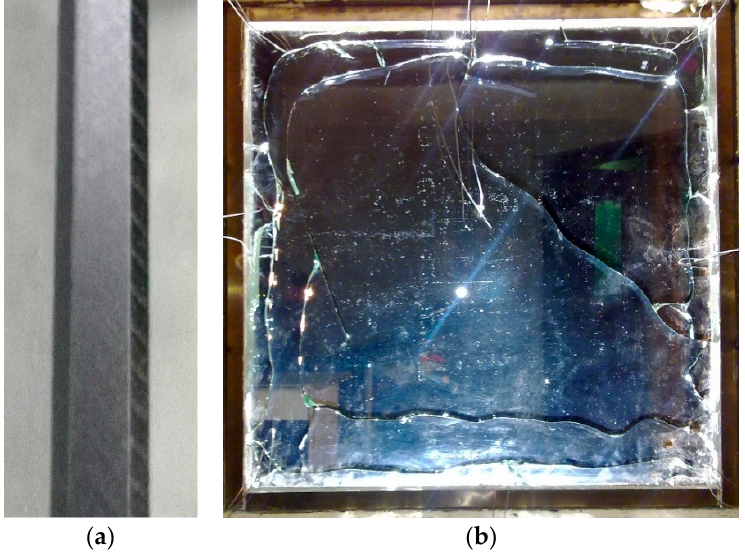
Figure 24. The ( a ) edge condition and ( b ) a typical crack pattern in a glass pane under thermal loading.